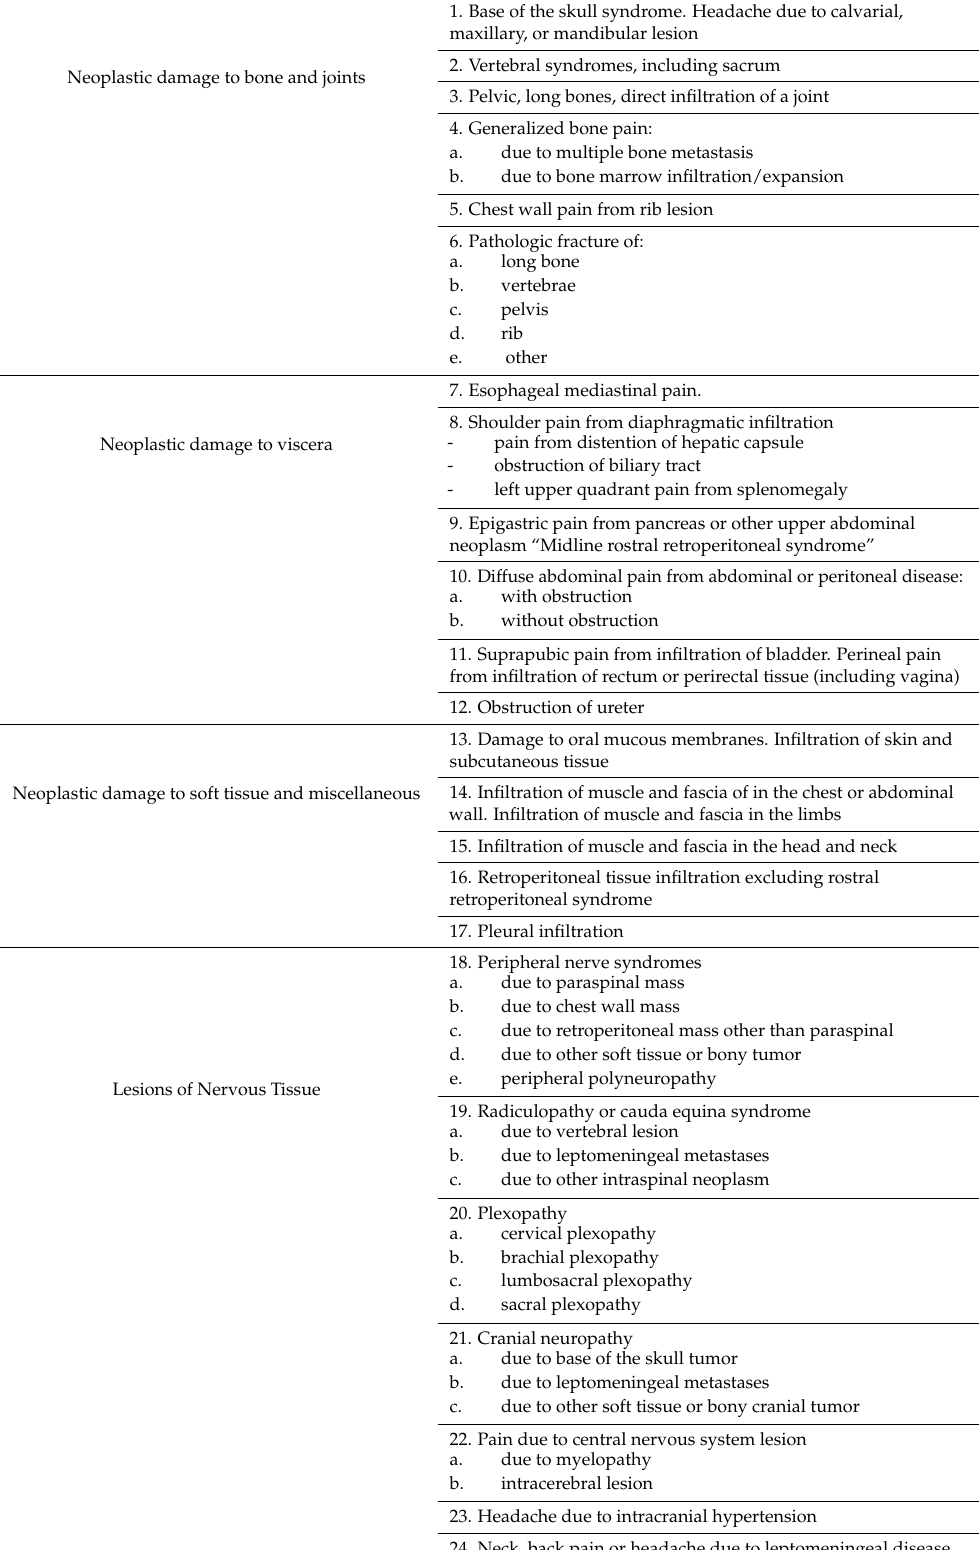
Table 1. Syndromic classification of pain caused directly by the solid tumor.